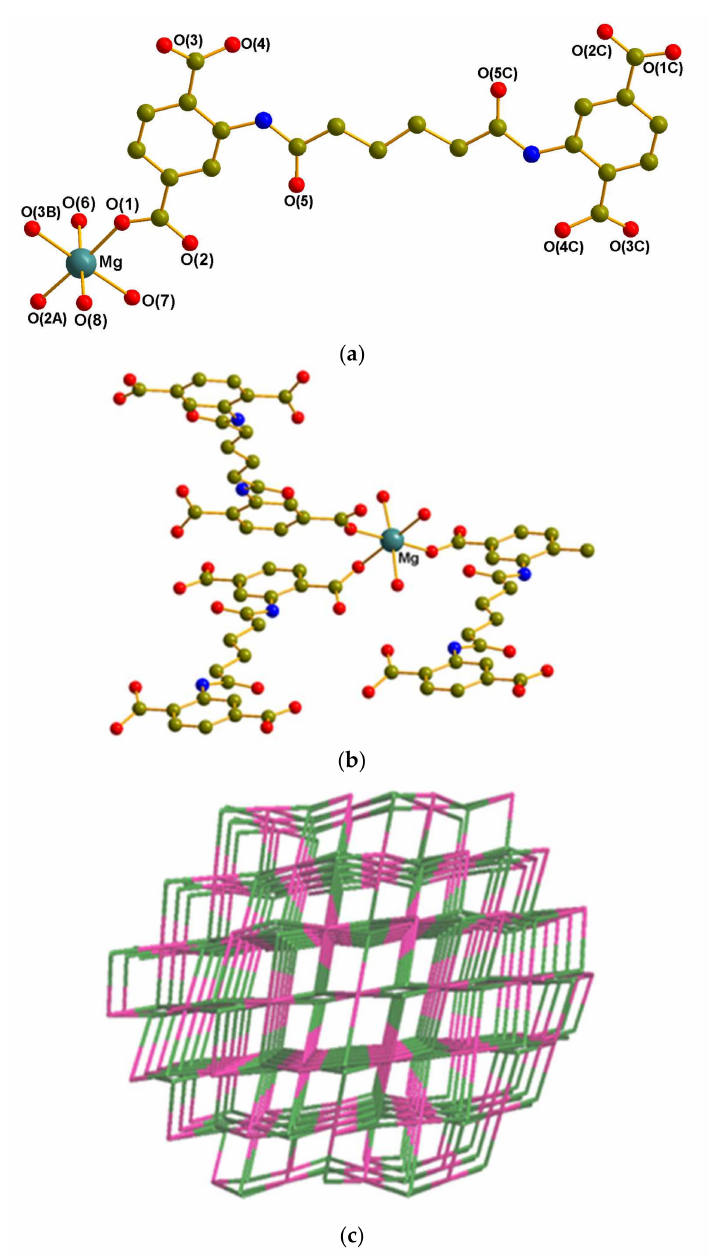
Figure 3. ( a ) Coordination environment of 3 ; Symmetry Code: (A) − x, y − 1/2, − z + 1 y − 1/2, − z + 1 ; ( b ) A view showing a Mg(II) unit as a 3-connected node; ( c ) 3D {4.6 2 } 2 {4 2 .6 10 .8 3 }- rtl 2 topological net of 3